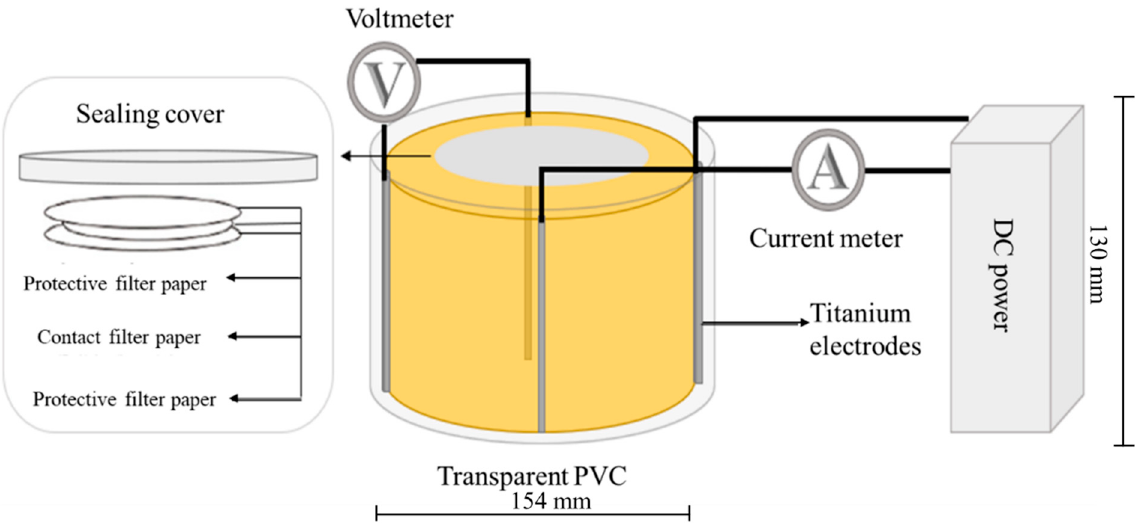
Figure 1. Schematic diagram of the test setup.